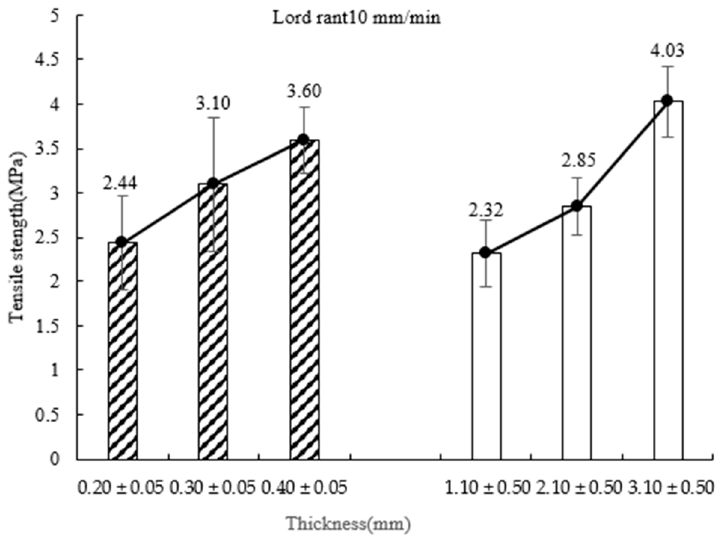
Figure 15. Tensile strength of wakame stem and leaf under different thickness.